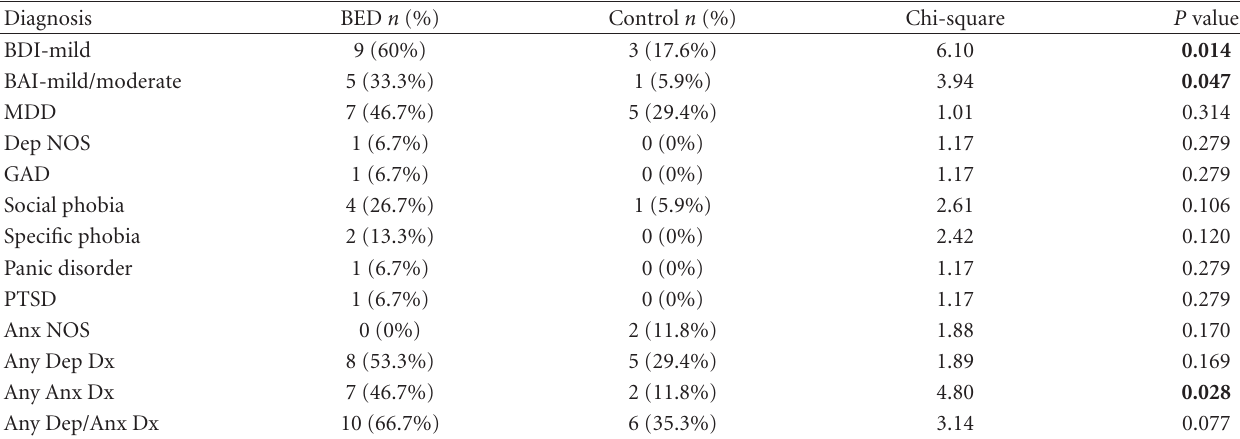
Table 2: Lifetime clinical depression and anxiety diagnoses by group.